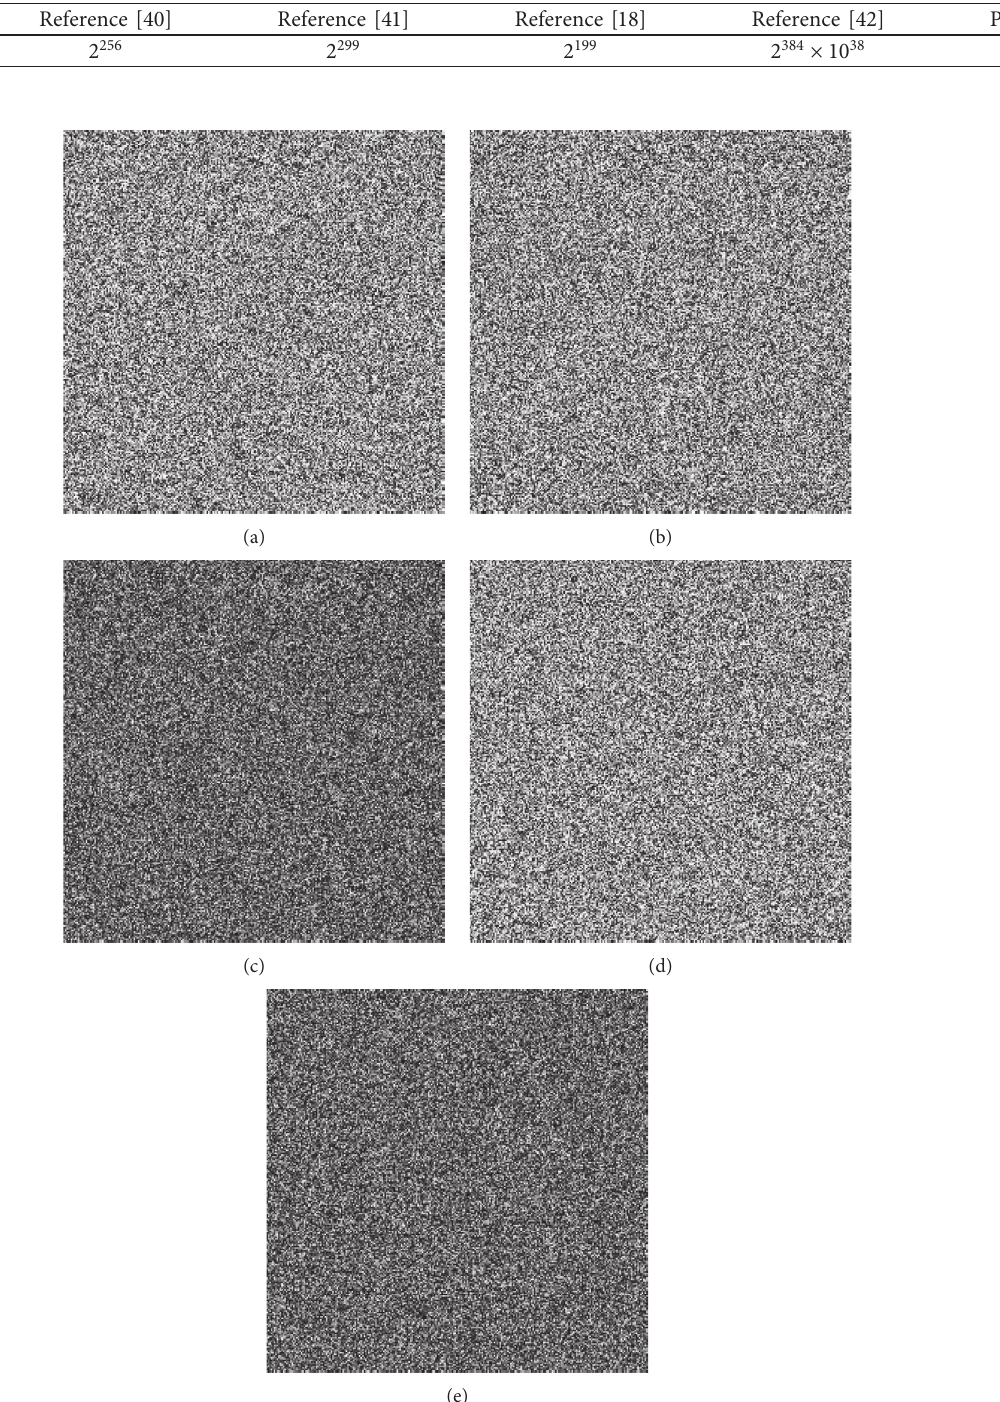
Table 5: Key space analysis.